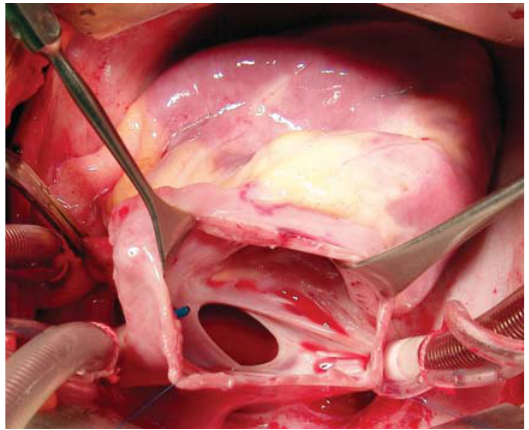
Fig. 4 – Átrio direito aberto demonstrando grande comunicação interatrial ostium secundum